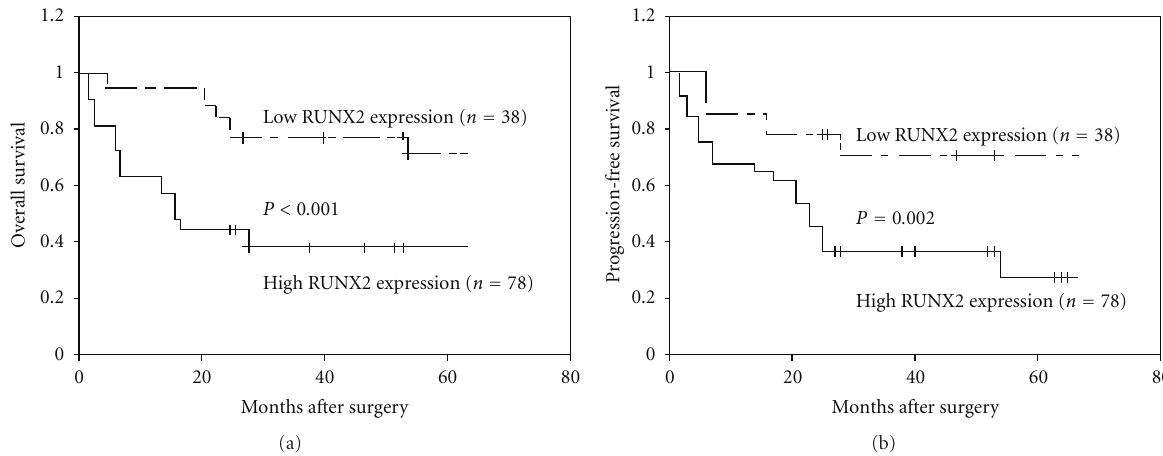
Figure 2: Kaplan-Meier overall (a) and progression-free (b) survival curves for epithelial ovarian cancer patients with high and low RUNX2 expression. Epithelial ovarian cancer patients with high RUNX2 expression had significantly shorter overall ( P < 0 . 001) and progression-free ( P = 0 . 002) survival than those with low RUNX2 expression did.